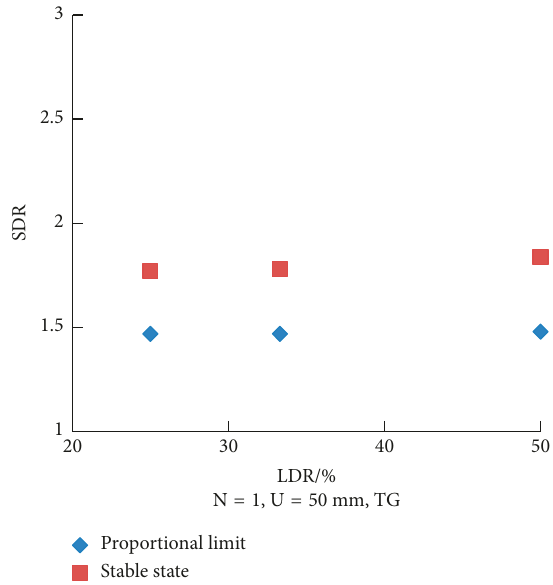
Figure 18: The relationship between SDR and LDR (TG; N 1; (cid:30) U (cid:30)